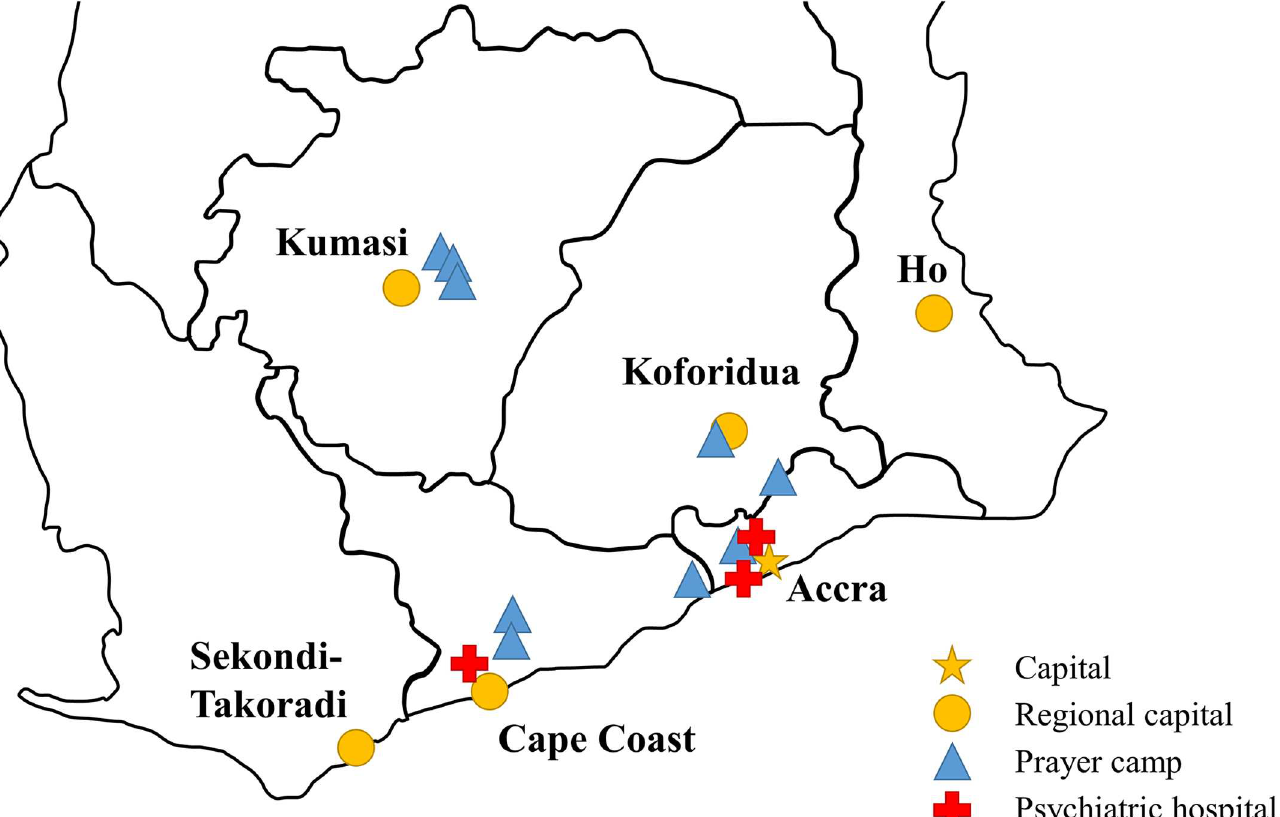
Fig 1. Map of SouthernGhanaand locationof prayer camps and